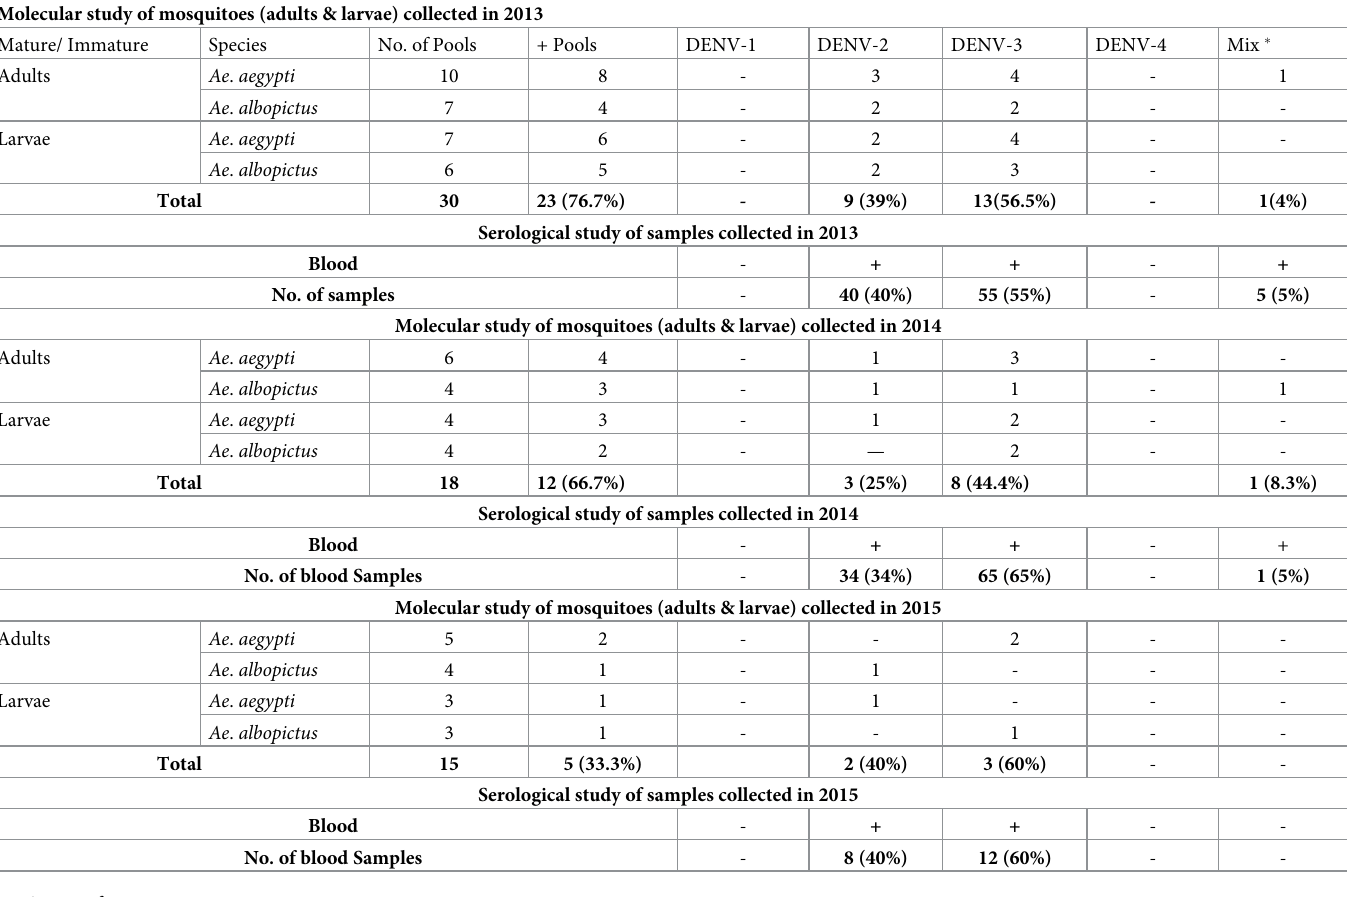
Table 1. Serotypes distribution (PCR based results) in mosquitoes and blood. Molecular study of mosquitoes (adults & larvae) collected in